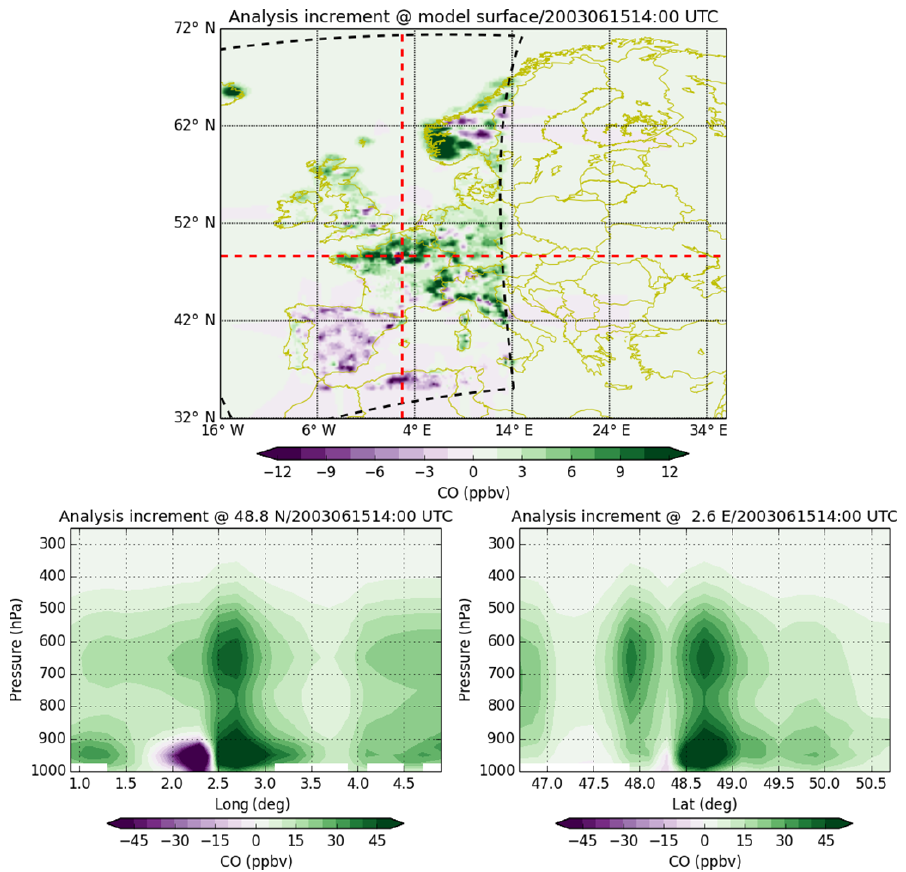
Figure 7. S-5P CO analysis increments, units of ppbv, at 14:00UTC on 15 June 2003. Top panel: geographical distribution at the model surface. Red dashed lines show zonal and meridional vertical slices at 48 ◦ 8 (cid:48) N and 2 ◦ 6 (cid:48) E, respectively. The black dashed line shows the S-5P cross-track at 13:12UTC, clipped to fit the OSSE simulation domain. Note that we measure the S-5P CO observations at 13:12UTC. The labels show longitude in degrees ( x axis) and latitude in degrees ( y axis). Left and right bottom panels show, respectively, the longitude– height and latitude–height cross sections at a location near Paris. The labels for the bottom panels show longitude in degrees ( x axis, left panel), latitude in degrees ( x axis, right panel), and pressure in hPa ( y axis, both panels). Green/purple colors indicate positive/negative values in the increment